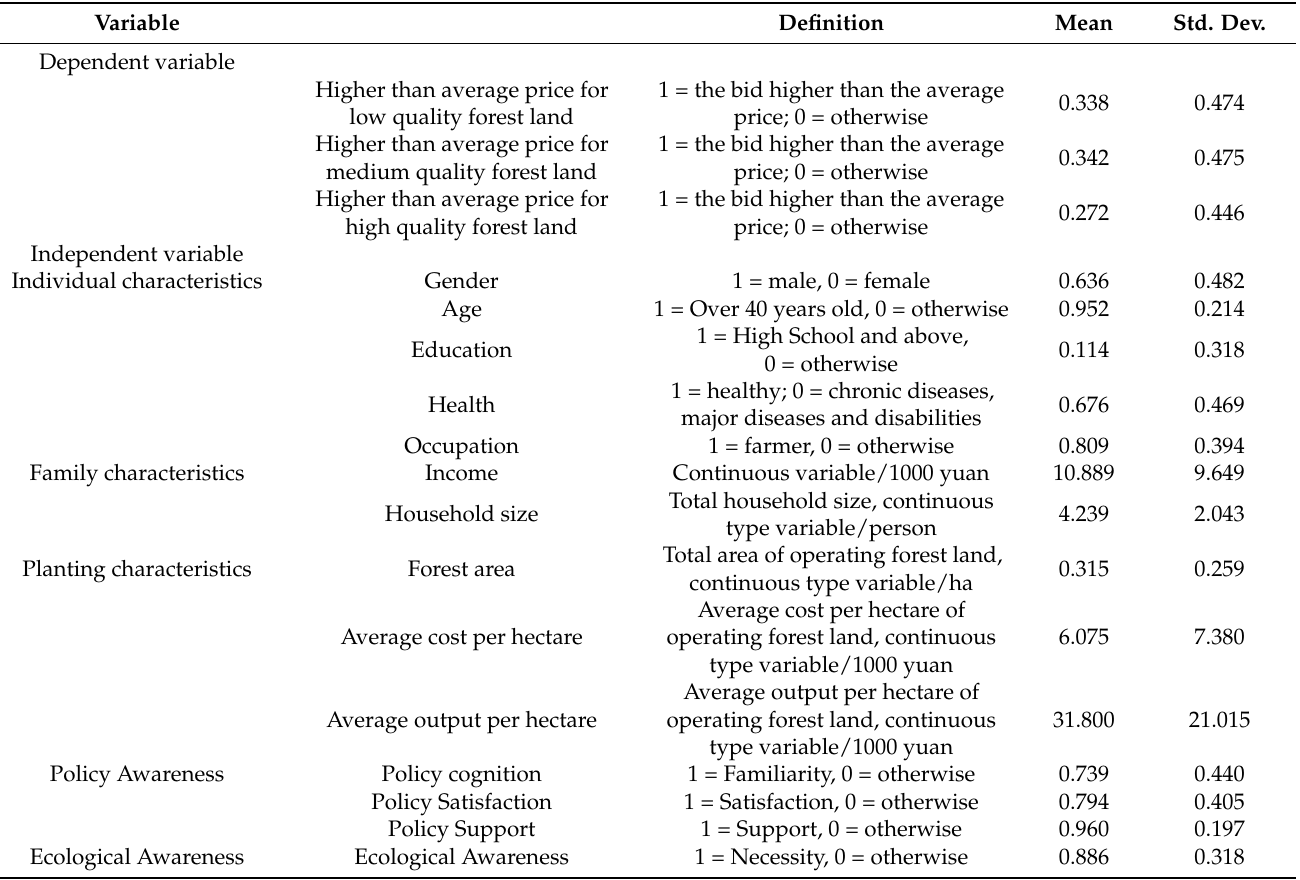
Table 2. Variable definitions and